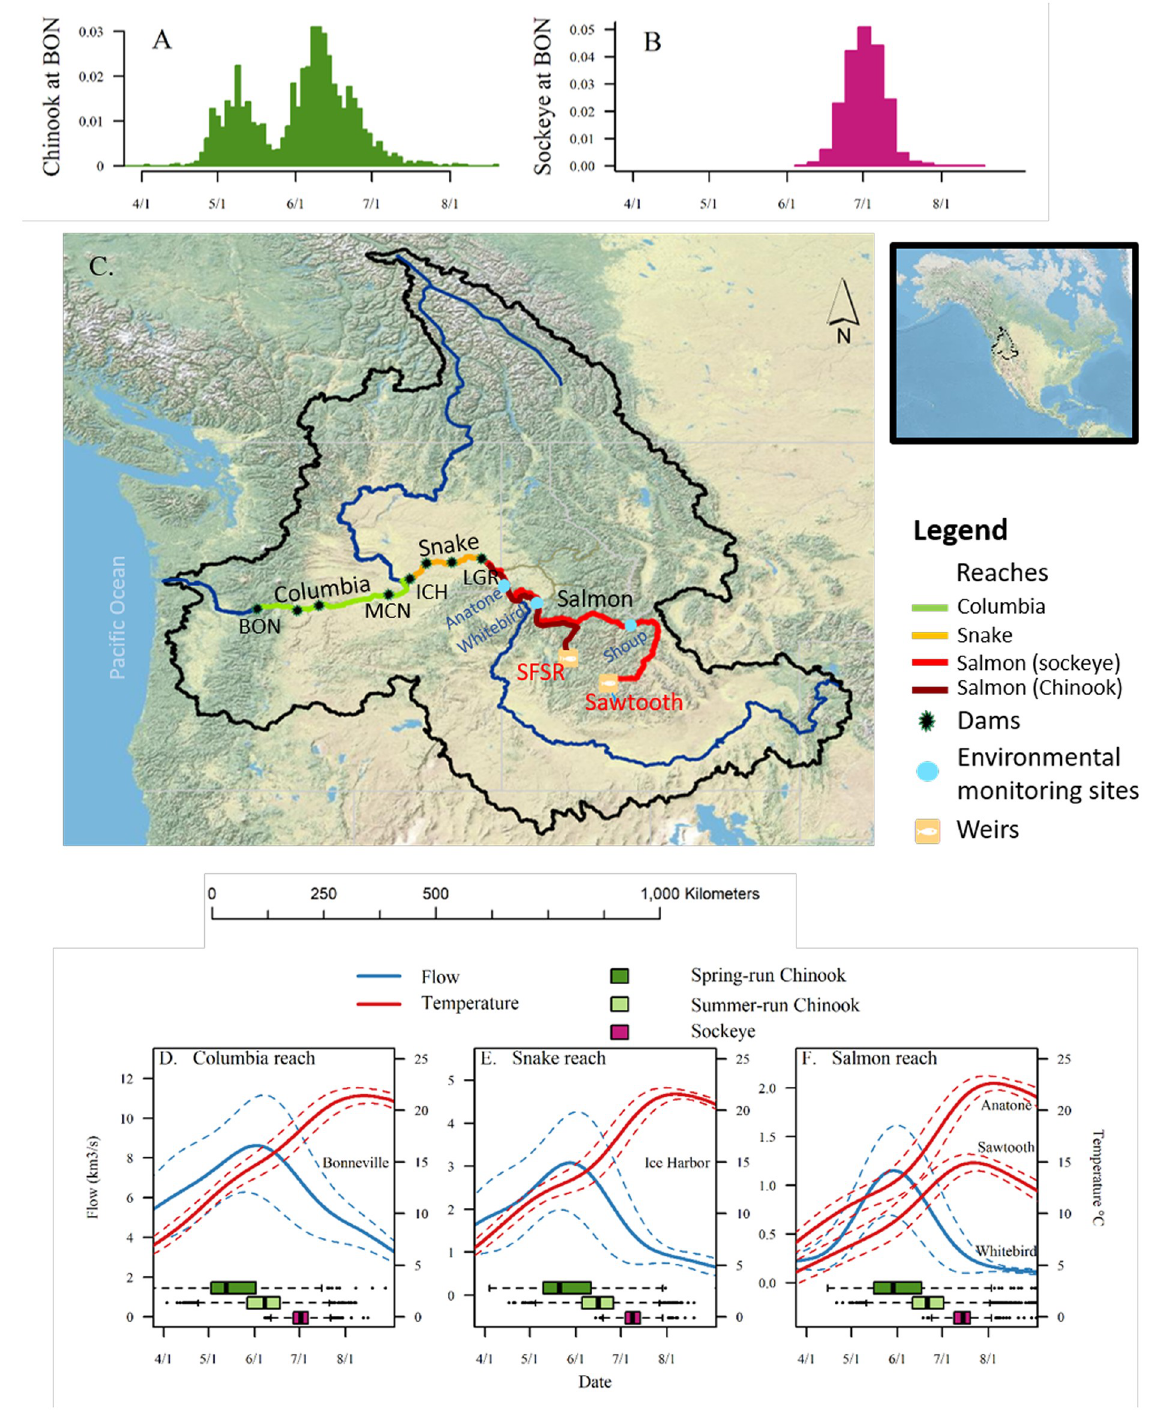
Fig 1. Overview of migration route, timing, and environmental conditions during each run. Histograms showing the frequency distribution of arrival timing of spring/summer Chinook (A) and sockeye salmon (B) at Bonneville Dam (BON). Map (C) shows migration reaches modeled, major dams, and other sites where environmental data were collected. Panels D-F show smoothed mean reach-specific daily mean temperatures and flows ( ± SD) during 2004-2016 with arrival dates at the respective dams (boxplots) for tagged Snake River spring/ summer Chinook and sockeye salmon. For the Columbia reach model (D), we relied on environmental data from Bonneville Dam. For the Snake reach model (E), we utilized environmental data from Ice Harbor Dam. The Salmon reach model (F) used temperature data from